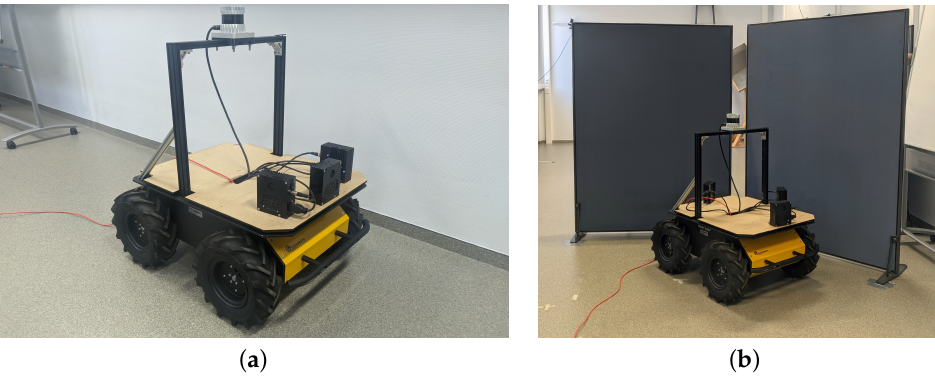
Figure 10. ( a ) The experimental setup with a Clearpath Husky UGV as mobile platform used for validating the controller behavior. This figure shows the setup with three mounted eRTIS sensors that each have a built-in NVIDIA Jetson TX2 NX module. Furthermore, an Ouster OS0-128 LiDAR sensor is mounted on the top and is used for 2D map generation during the validation experiments. ( b ) A photo of the UGV taken during one of the experiments. More specifically, the avoidance of a direct wall collision. Subfigure ( a ) was moved from Figure 1 to better fit the paper structure. Subfigure ( b ) was added to show one of the setups.